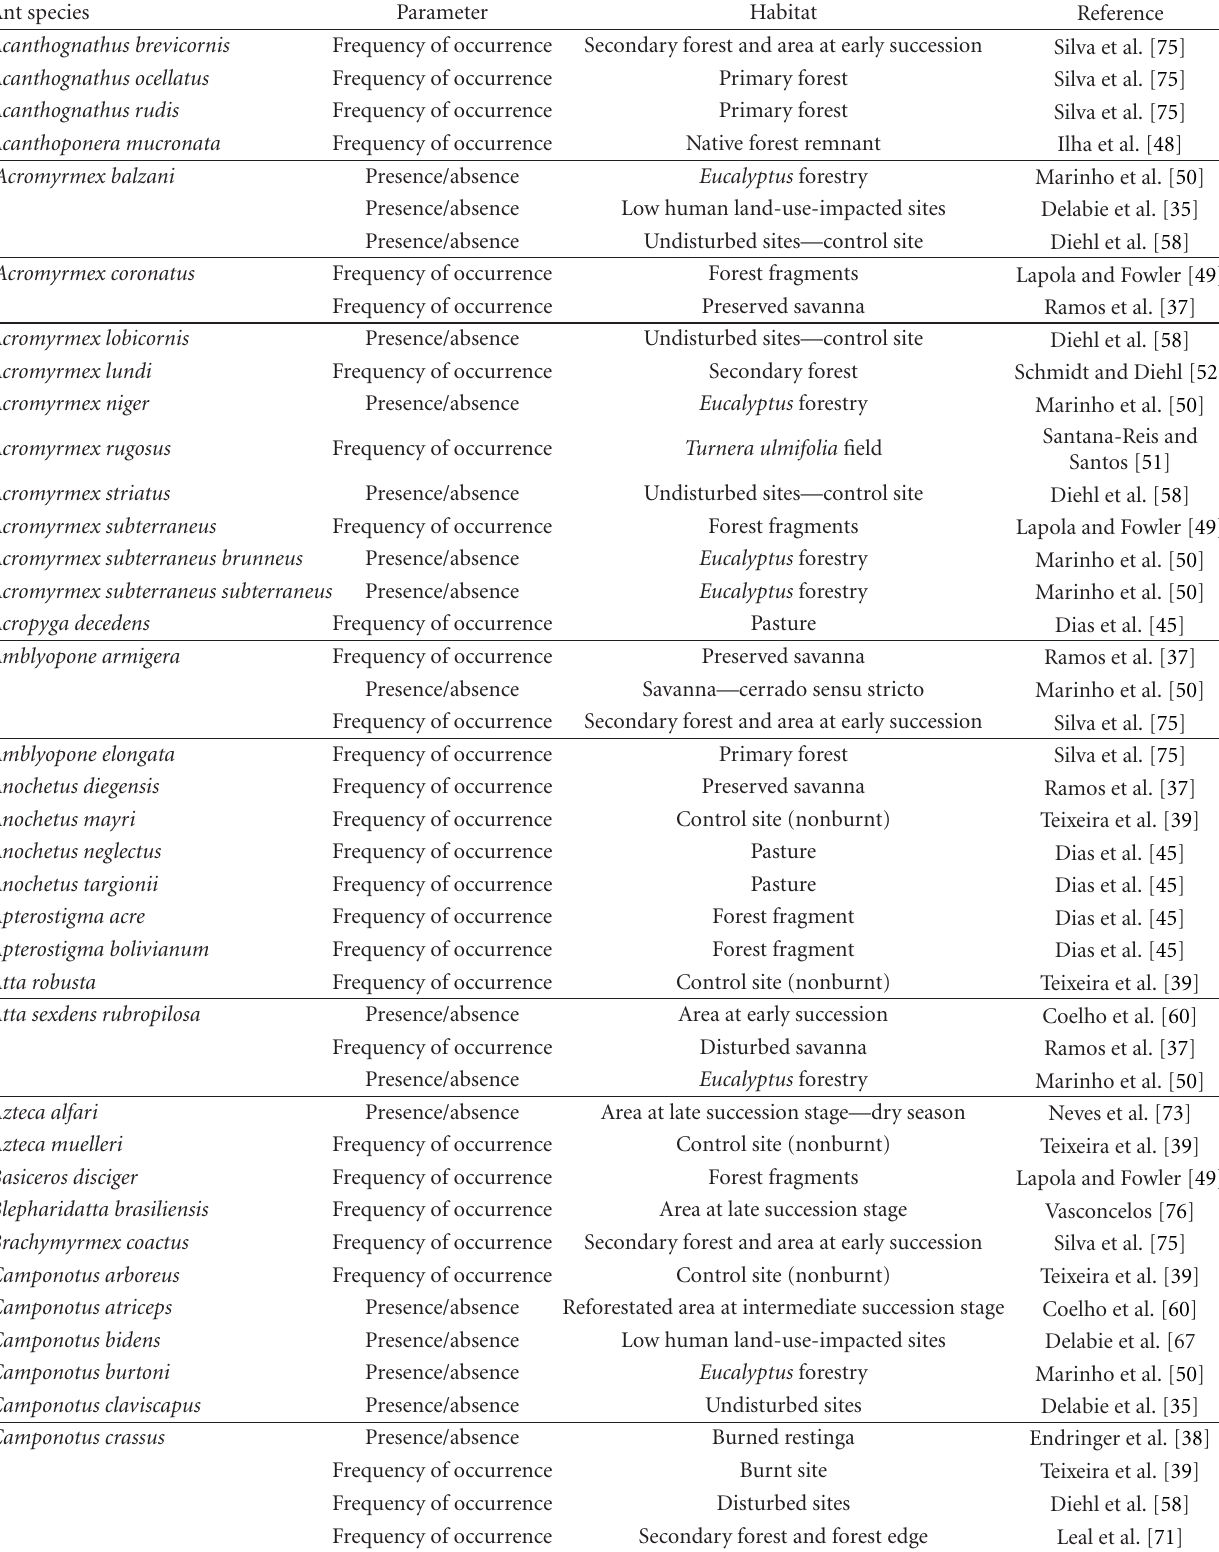
Table 2: Species of ants defined as indicators, indicating the parameter used by the authors (Parameter) when linking each ant species to each habitat type (Habitat) and the paper